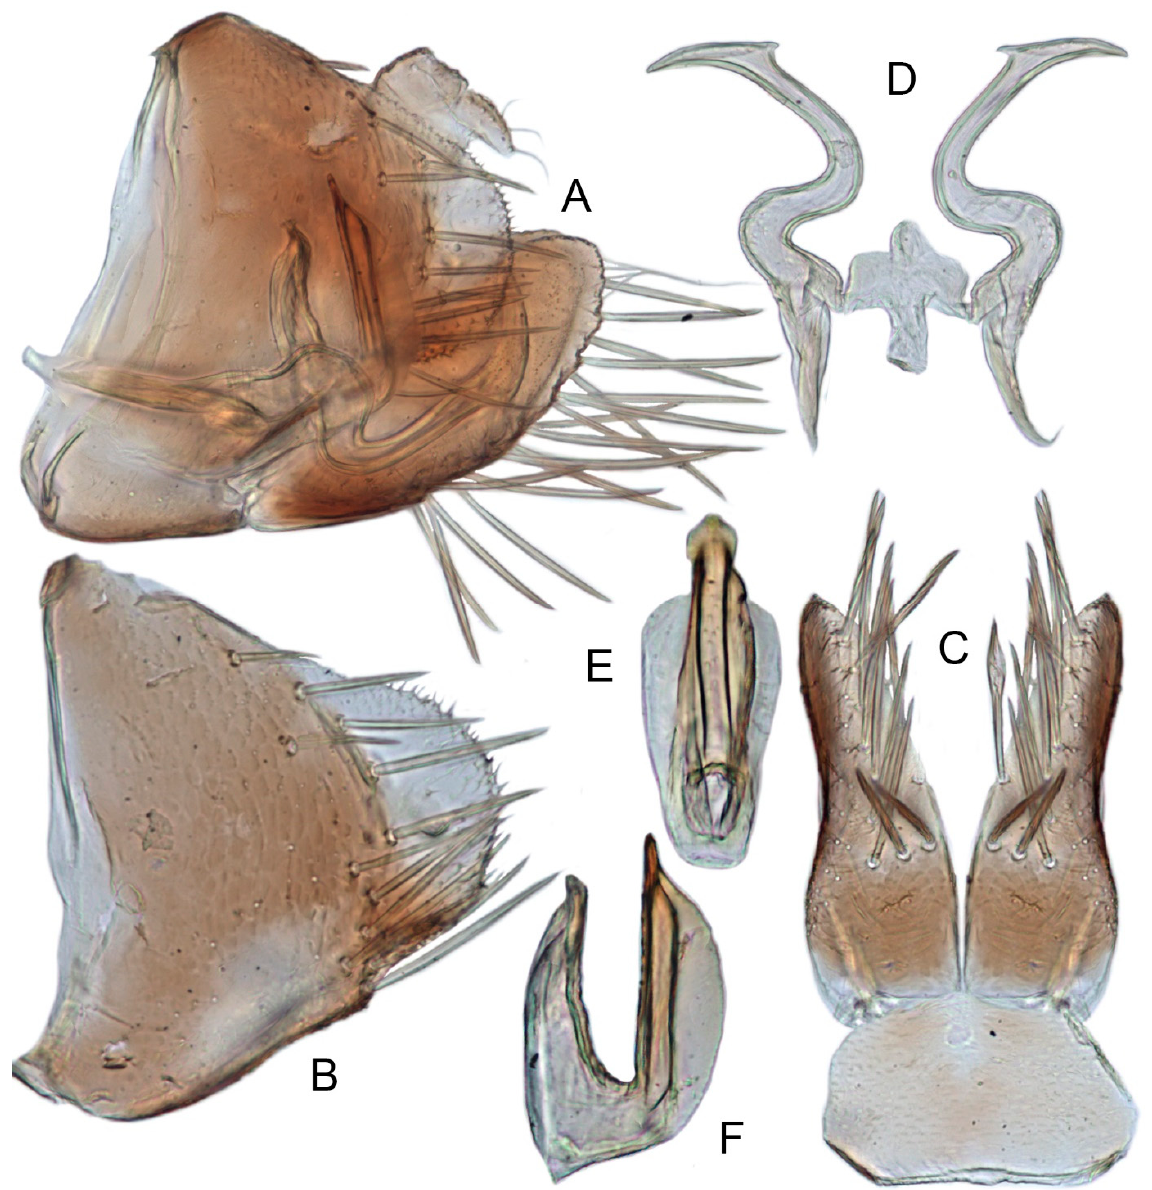
Figure 3. Xestocephalus guttulatus (Motschulsky, 1859), ( A ) Male genital capsule, lateral view; ( B ) pygofer lobe, lateral view; ( C ) Subgenital plates and valve, ventral view; ( D ) Style and connective, ventral view; ( E ) Aedeagus, posterior view; ( F ) aedeagus, lateral view.